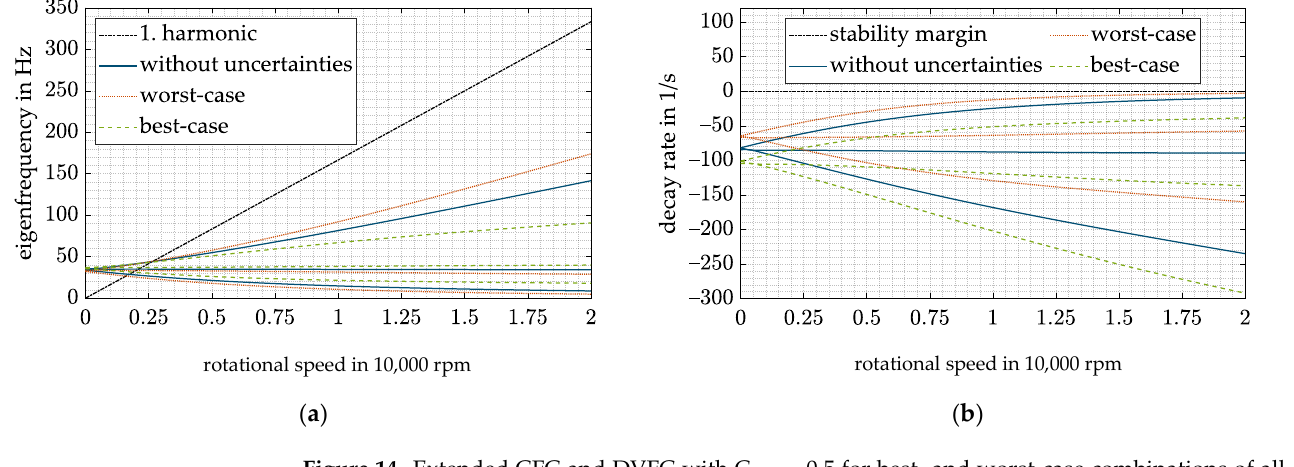
Figure 14. Extended CFC and DVFC with C att = 0.5 for best- and worst-case combinations of all uncertainties: ( a ) Campbell diagram; ( b ) decay rate.